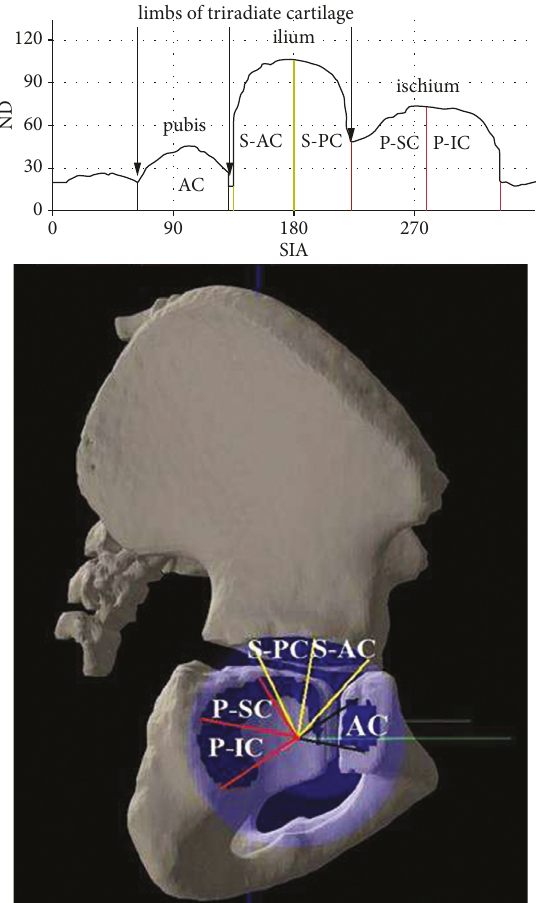
Figure 2: The graphical presentation of FH coverage by different acetabular regions. AC: anterior coverage; S-AC: superior-anterior coverage; S-PC: superior-posterior coverage; P-SC: posterior-su- perior coverage; P-IC: posterior-inferior